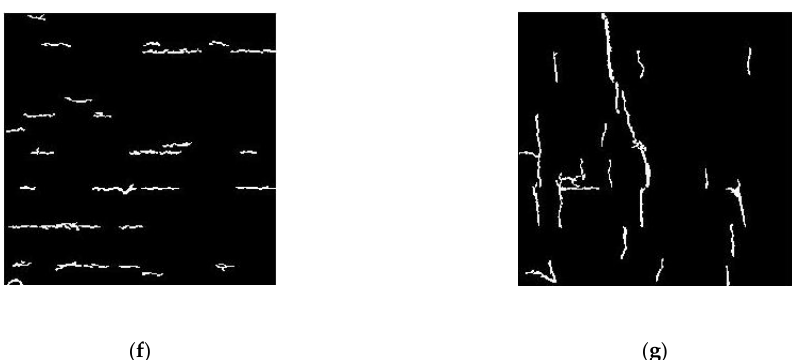
Figure 14. Evaluation of the algorithm on surface images of earthen heritage. ( a ) Image 1, ( b ) horizontal edge map, ( c ) vertical edge map, ( d ) horizontal CCs (area > 30 pixels), ( e ) vertical CCs (area > 30 pixels), ( f ) architectural feature map and ( g ) crack map.